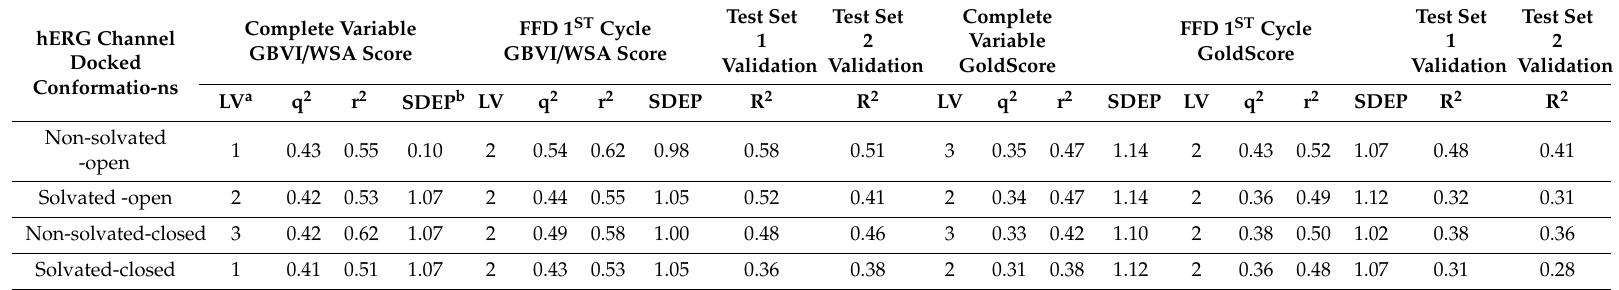
Table 2. Statistics of the PLS models based on various docked conformations up to first cycle of (Fractional Factorial Design) FFD. Bold values showing final model